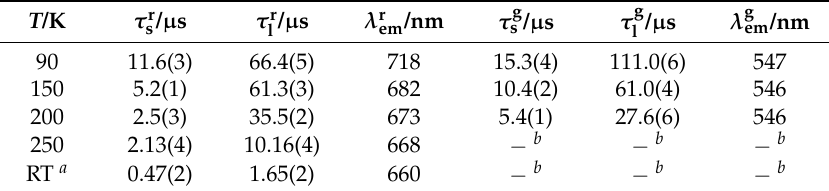
Table 3. The Cu 4 complex solid-state luminescence lifetimes ( (cid:2028) ) and emission peak maxima ( (cid:2019) (cid:2915)(cid:2923) ) obtained from the least-squares fit at various temperatures ( (cid:1846) ). (cid:2028) (cid:2922) and (cid:2028) (cid:2929) denote longer and shorter lifetime, respectively; “r” and “g” superscripts denote parameters for red- and green-light emission maxima, respectively.